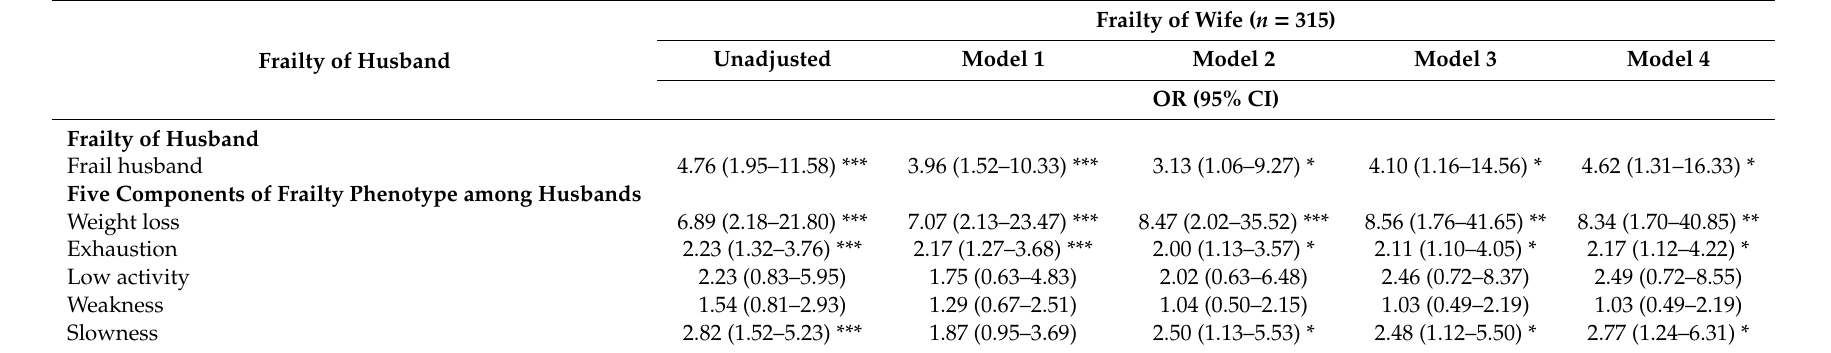
Table 4. Wife’s odds of frailty when the husband is frail in 315 married